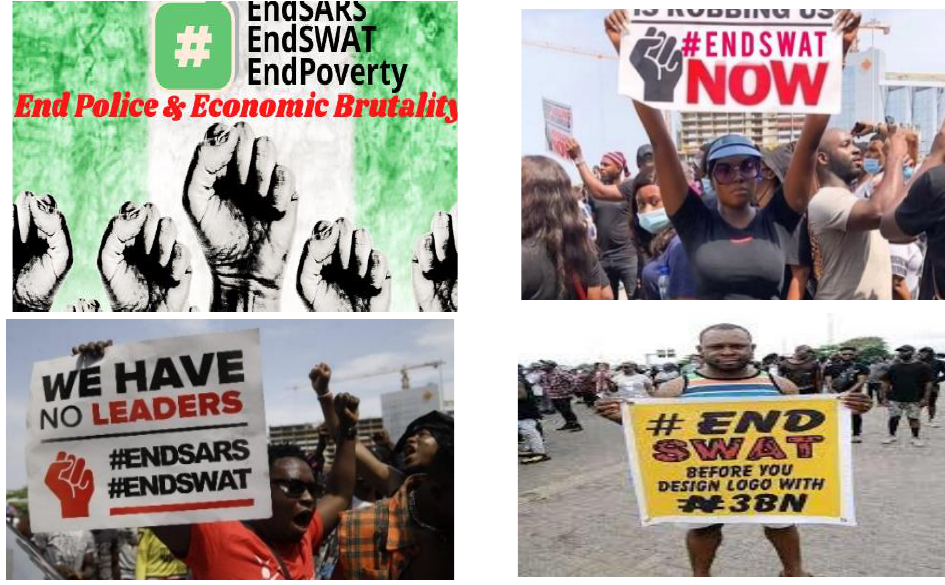
Figure 8: New protests hashtags; Source: Eco Information 2020; Anwana, 2020; Tero